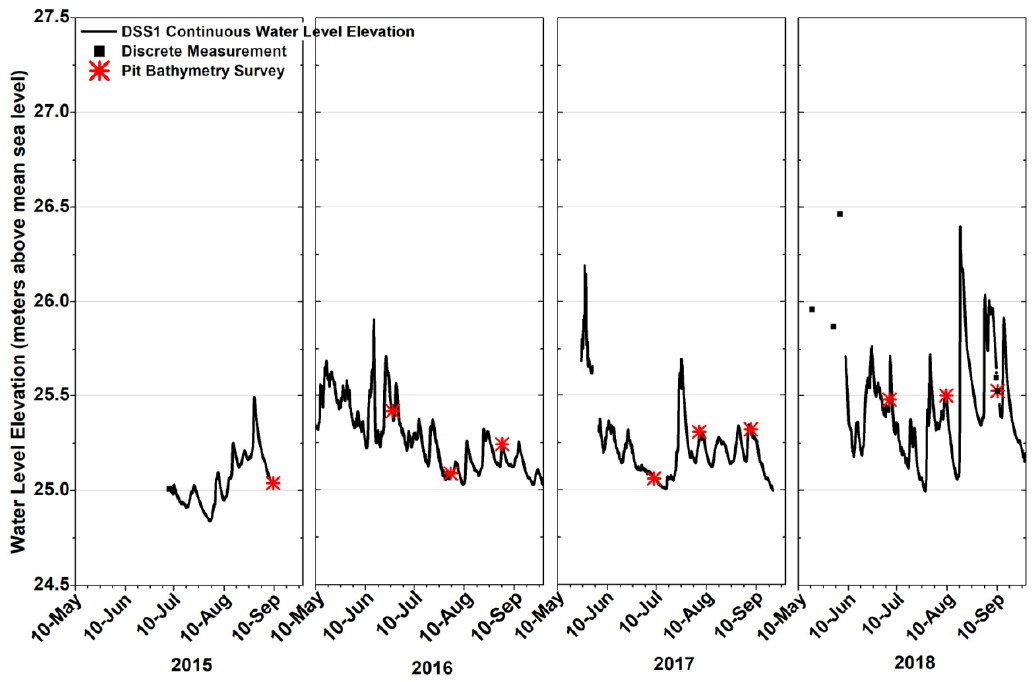
Figure 4. Water level elevations during the study period at station MP405 (DSS1).